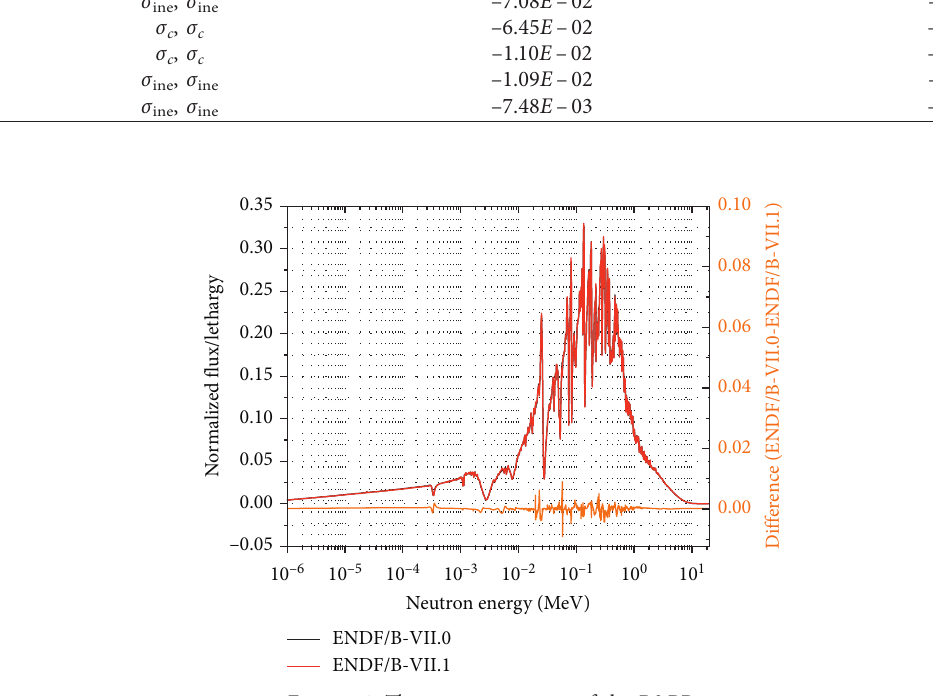
Figure 4: The neutron spectra of the